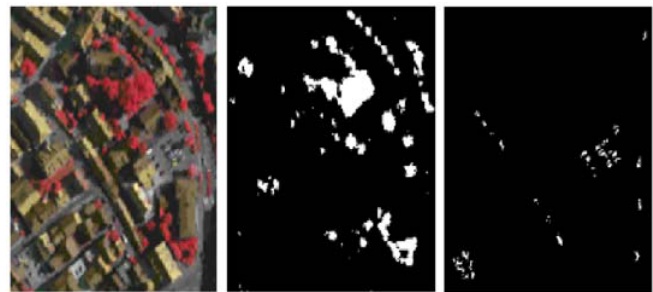
Figure 6: Classification maps of dataset Vaihingen with image(left), trees(middle) and vehicles(right).